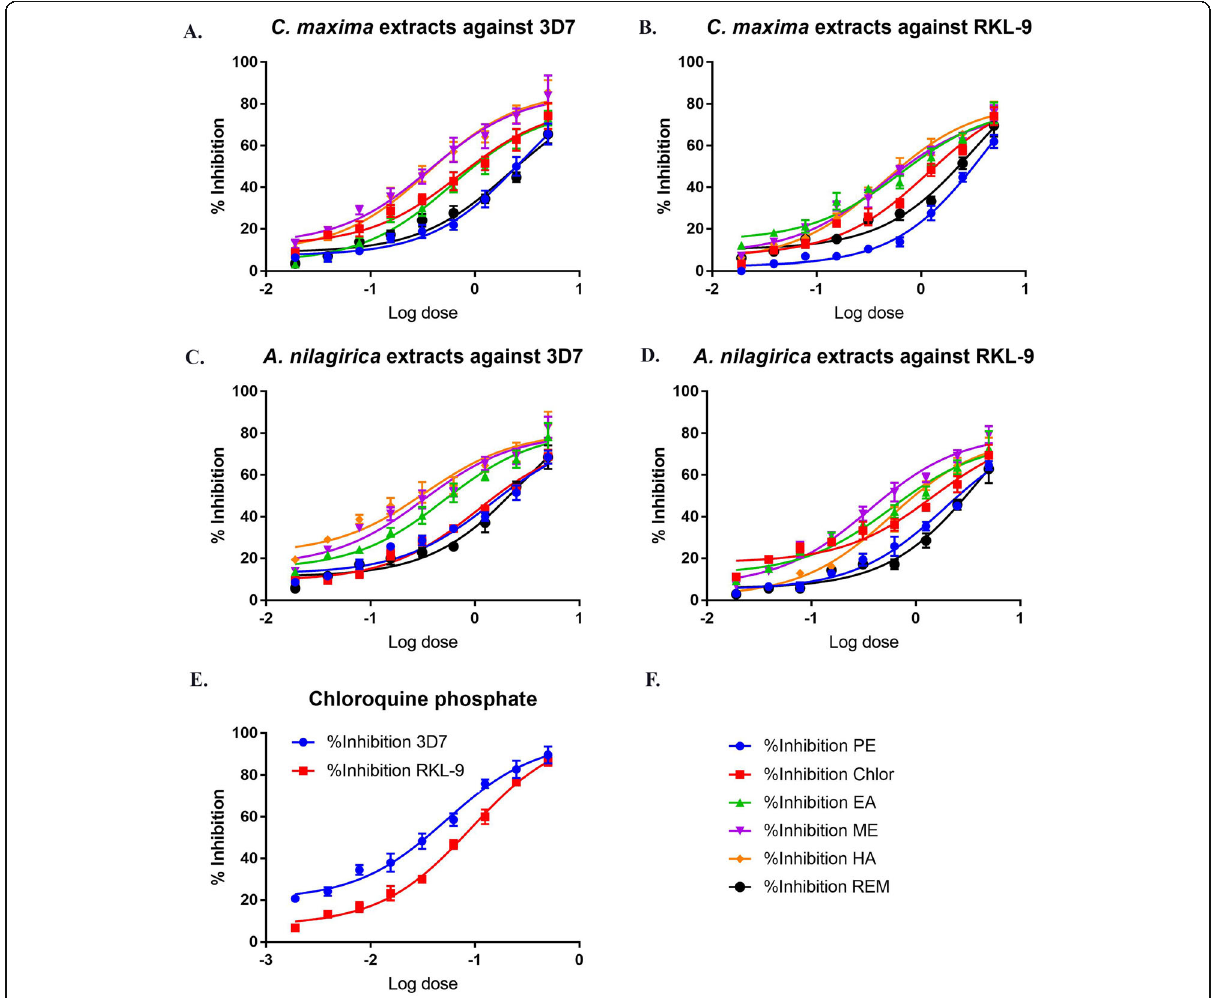
Fig. 1 Calculation of IC 50 values by non-linear regression analysis (GraphPad Prism) using nine different concentrations with two-fold serial dilution. For the test extracts the dilution was made from 50 μ g/ml to 0.195 μ g/ml whereas for the standard drug the dilution was made from 5 μ g/ml to 0.019 μ g/ml. The experiment was performed in triplicates and each value is the mean ± SD of three